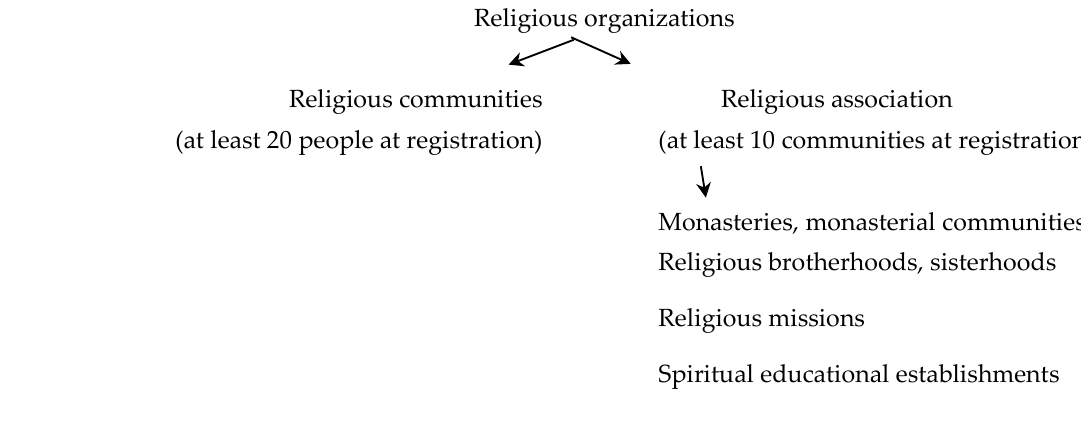
Figure 1. Requirements of the religious organization headcount for obtaining state registration in the Republic of Belarus.